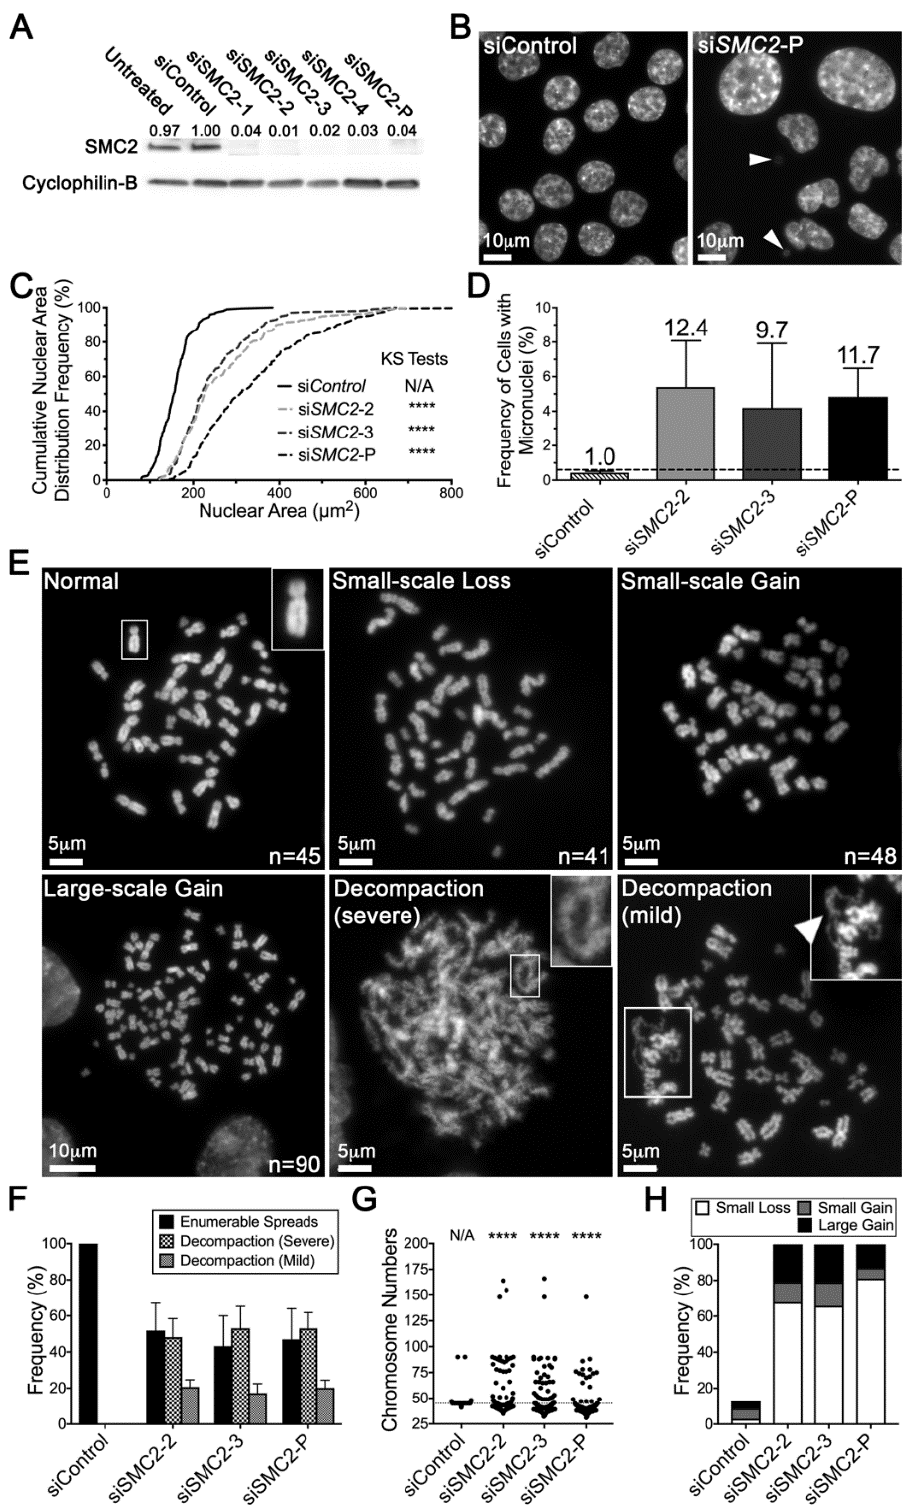
Figure 3. SMC2 silencing induces CIN phenotypes in HCT116 cells. ( A ) Western blot showing SMC2 levels following silencing with either individual (si SMC2 -1, -2, -3, or -4) or pooled (si SMC2 -P) siRNA duplexes; Cyclophilin B is the loading control. Semi-quantitative image analysis was performed where SMC2 levels were first normalized to the respective loading control and are presented relative to siControl (1.00). See Figure S1 for detailed information. ( B ) Representative images depicting visual increases in NA heterogeneity and MN formation (arrowheads) following SMC2 silencing relative to siControl. ( C ) Cumulative NA distribution graph for SMC2 silenced conditions relative to